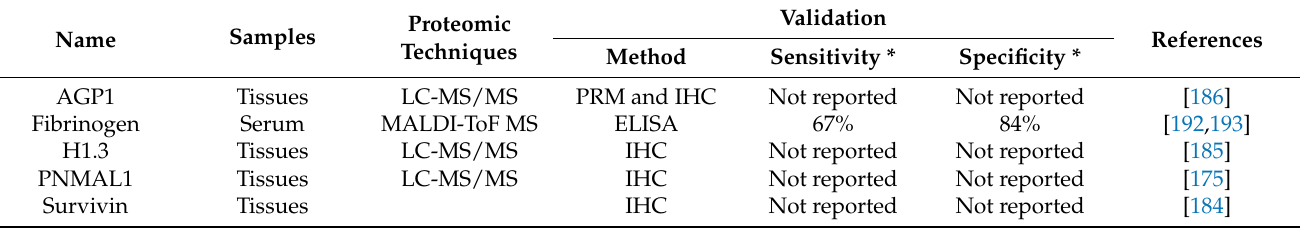
Table 3. Recently identified prognostic biomarkers for PDAC using proteomics